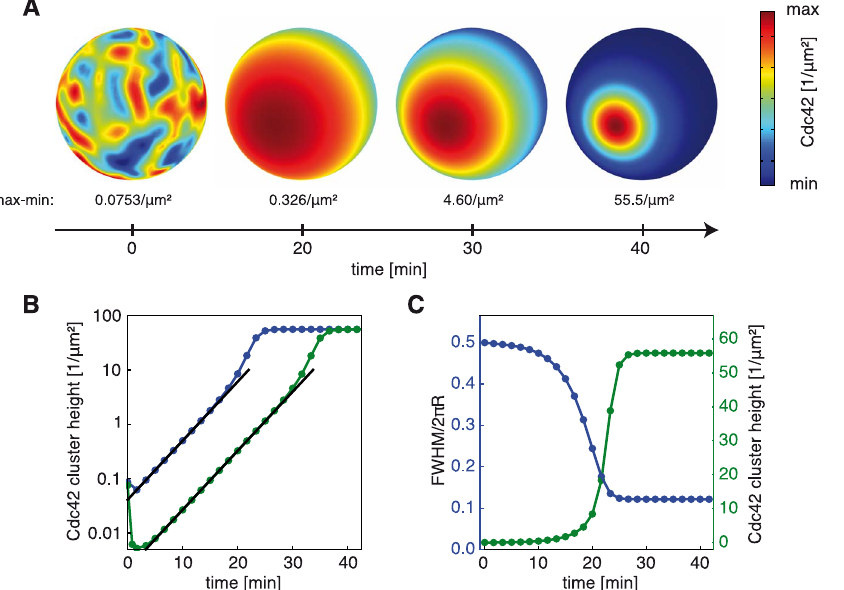
Figure 2. Predicted dynamics of GDI-mediated polarization. A Cdc42 density on the plasma membrane for different points in time as obtained from numerical simulations (Movie S1) starting from the unpolarized homogenous solution disturbed by a small random perturbation using control cell parameters. B Development of simulated Cdc42 cluster height (maximum density over background) over time starting with a random initial perturbation (green curve) or using a broad cap as initial perturbation (blue curve). The black lines correspond to a growth rate of the corresponding cluster of 0.00417 s 2 1 as predicted from the linear stability analysis. C Full width at half maximum (FWHM) of simulated Cdc42 cluster height measured along a great circle through the cap center over circumference 2 p R (blue) and simulated Cdc42 cluster height (green) with a broad faint cap as initial perturbation for different points in time.